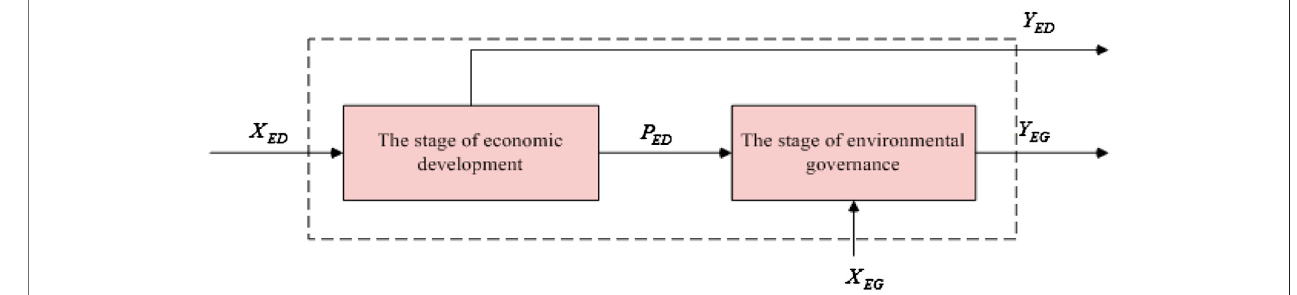
FIGURE 2 | The Stages of